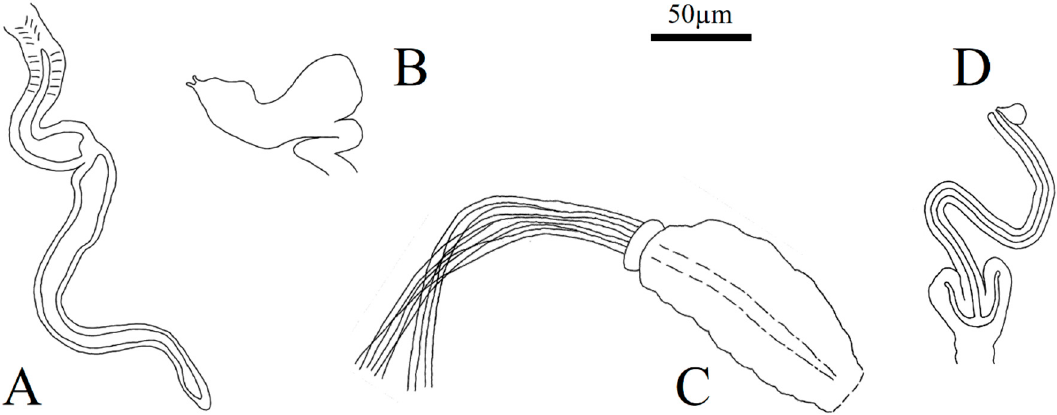
Figure 1. Several features of the holotype Fridericia gongalskyi sp. nov. ( A ) Oesophageal appendage.